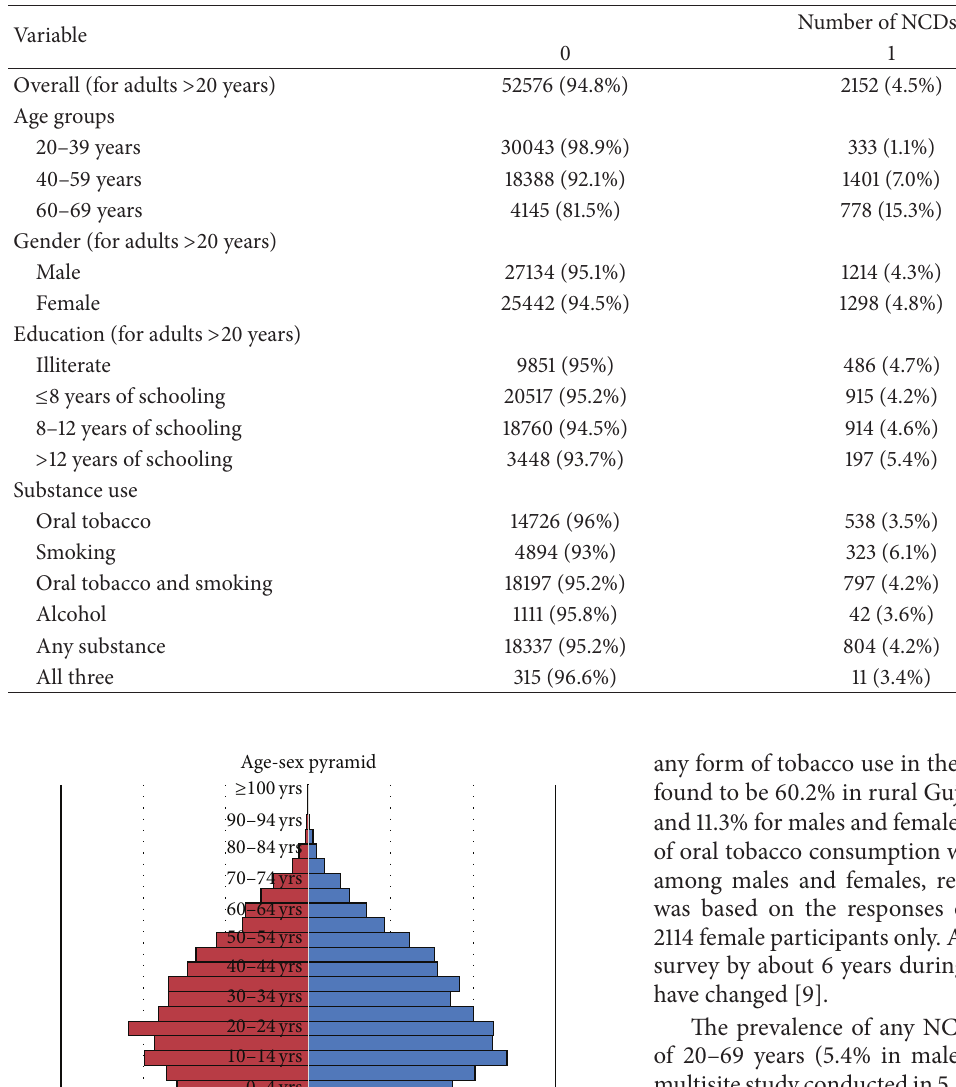
Table 5: Association between number of NCDs with other variables (age group 20–69 years).